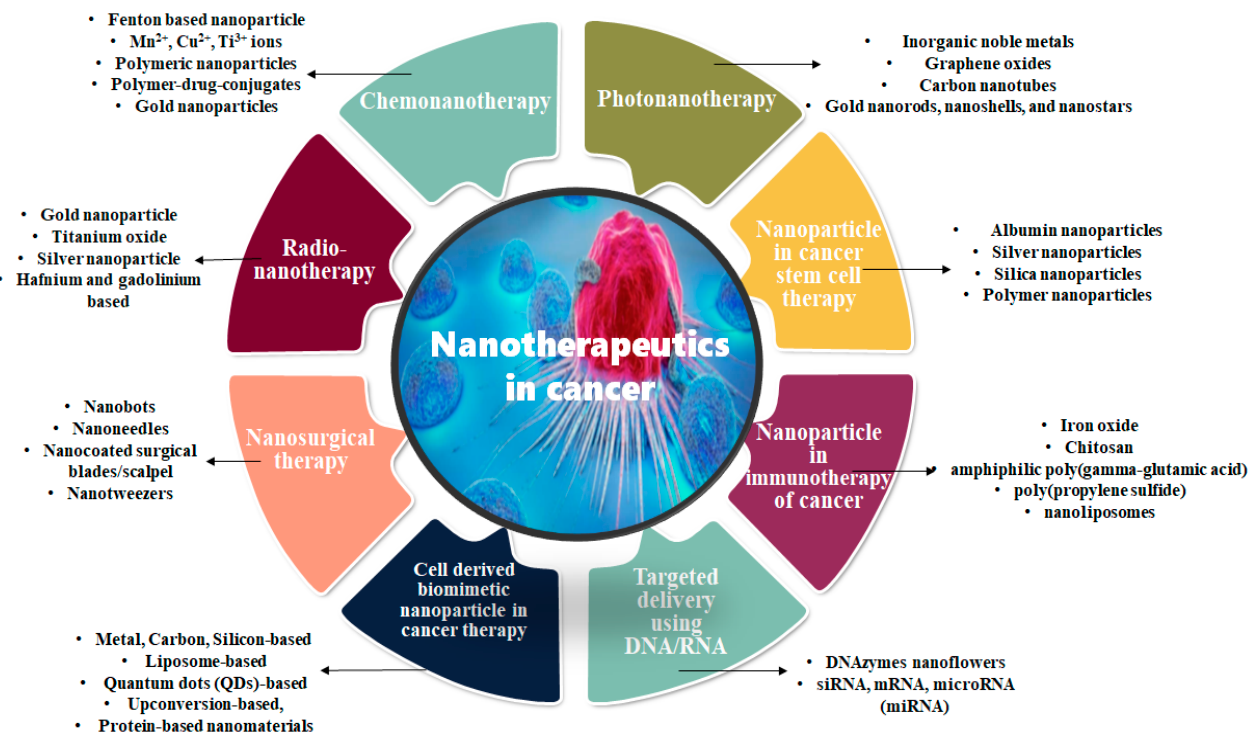
Figure 1. Nanoparticles in different types of cancer therapies.